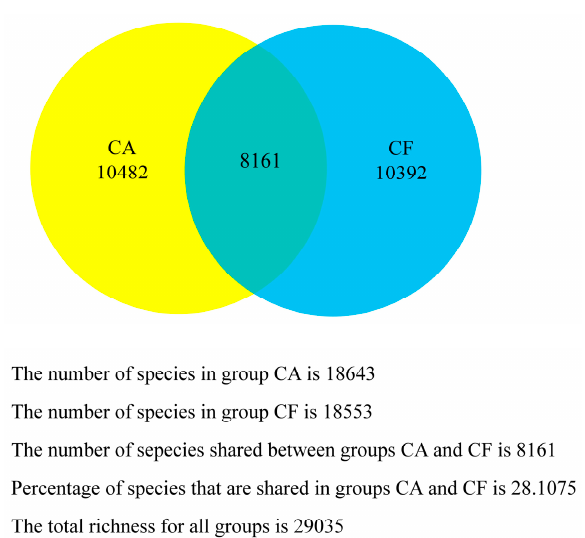
Figure 5. Venn diagram of the number of OTUs shared and unshared in the caries-affected (CA) and caries-free (CF) groups.